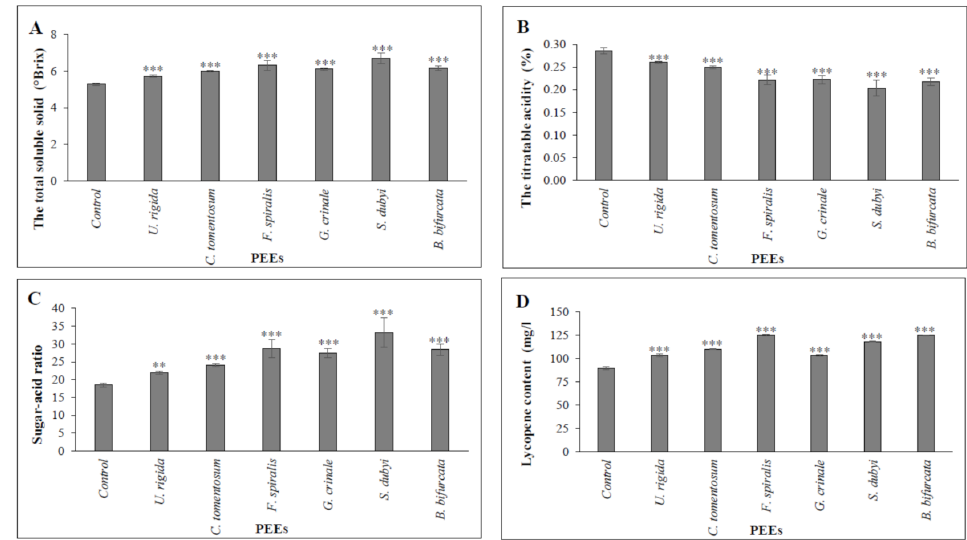
Figure 2. Quality parameters of fruits harvested from tomato plants treated 4 times (1 application after transplantation, 2 applications during the vegetative phase of growth, and 1 last application during the reproduction phase) with PEEs treatments and untreated control plants. ( A ) Total soluble solid content expressed in Brix degree. ( B ) Titratable acidity (% citric acid). ( C ) Sugar-acid ratio. ( D ) Lycopene content. The data represent the mean values of 6 repetitions with standard deviations indicated by vertical bars. * Significant difference compared to the control treatment by ANOVA analysis ( p ≤ 0.05) *** = p ≤ 0.001; ** = p ≤